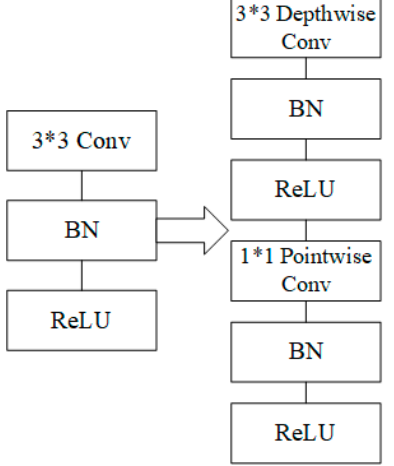
Figure 2. Variation of standard convolution compared to MobileNet convolution.